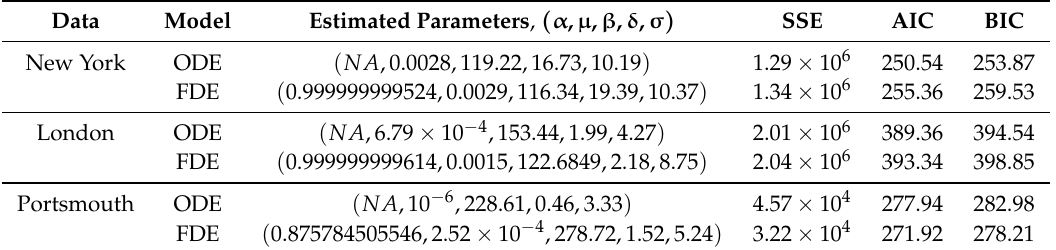
Table A4. Parameter estimation and statistical measures of fittings for the classical ODE model and FDE model using different data